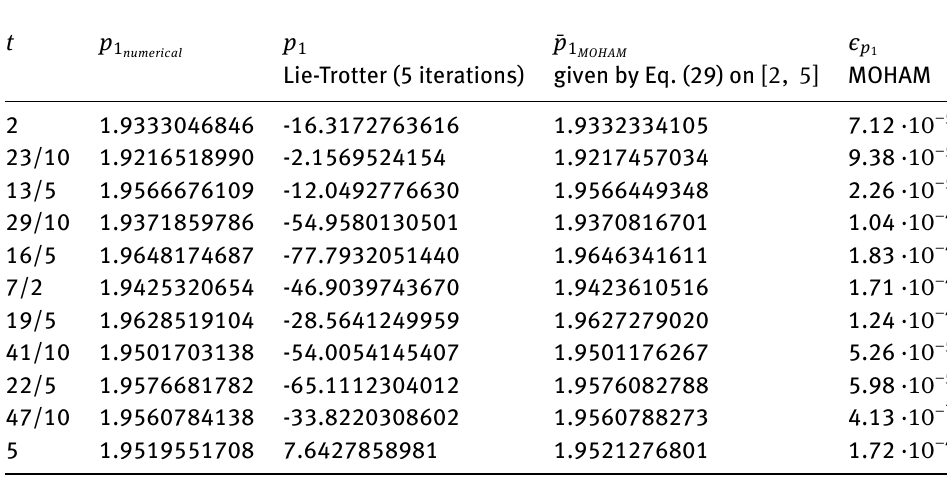
− ¯ p 1 | MOHAM numerical